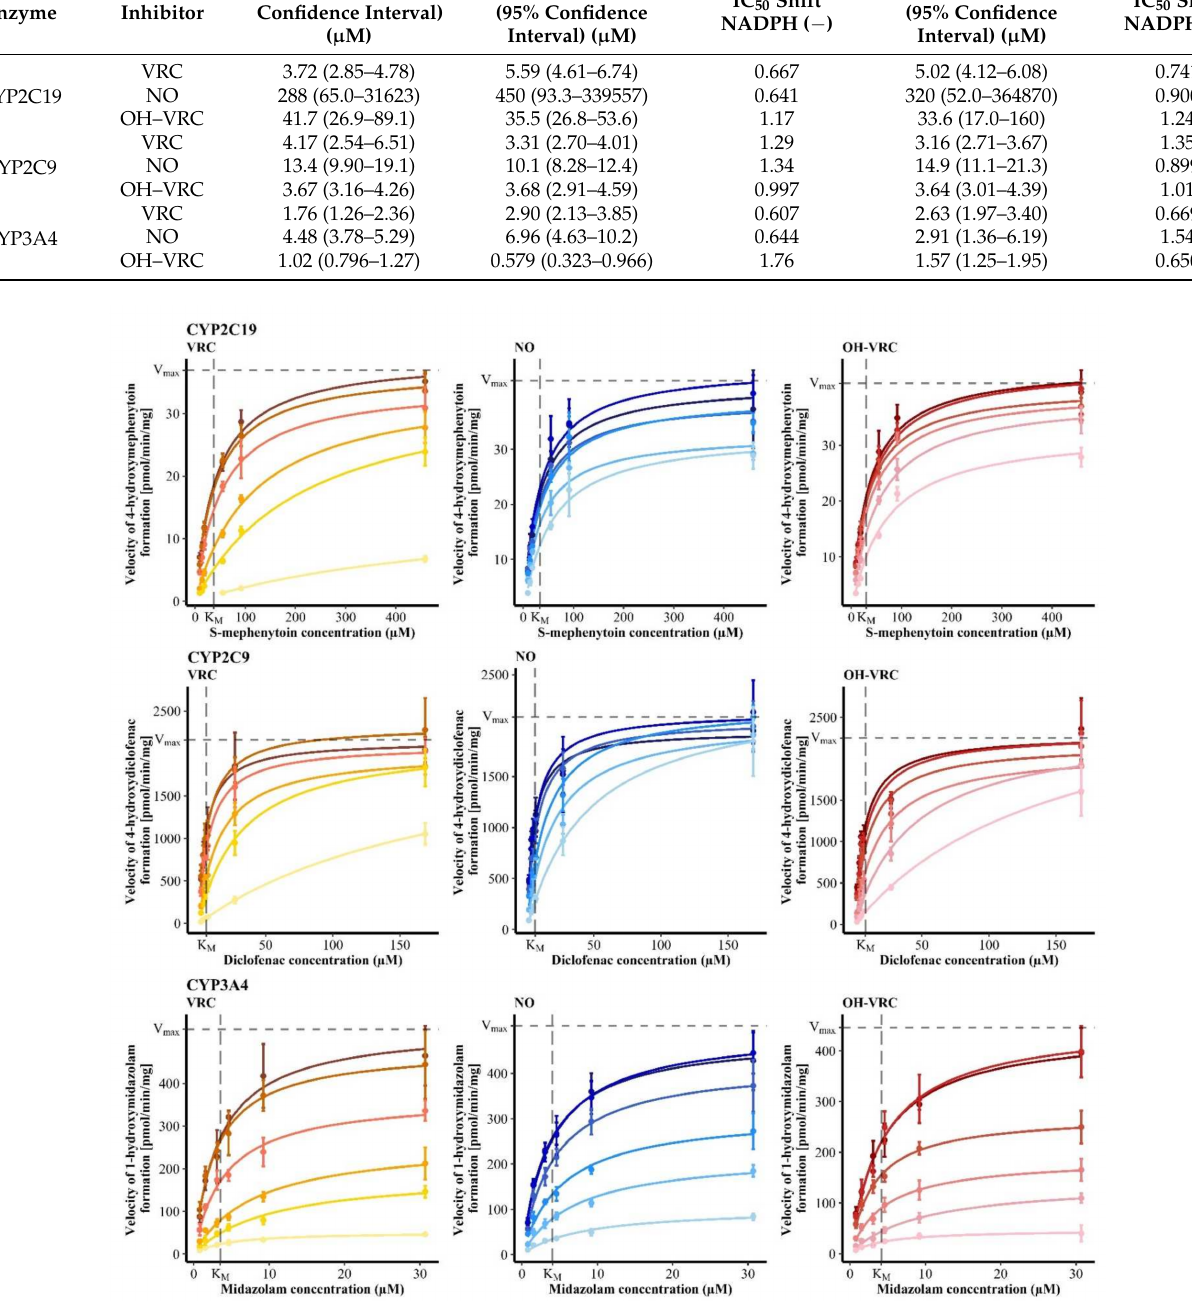
Table 3. Concentrations of voriconazole (VRC), voriconazole N -oxide (NO) and hydroxyvoriconazole (OH–VRC) causing a half maximum inhibitory effect (IC 50 ) on the CYP enzymes 2C19, 3A4 and 2C9 without a pre-incubation period (IC 50 ) and with a 30 min pre-incubation in the absence ( − ) or the presence (+) of NADPH.